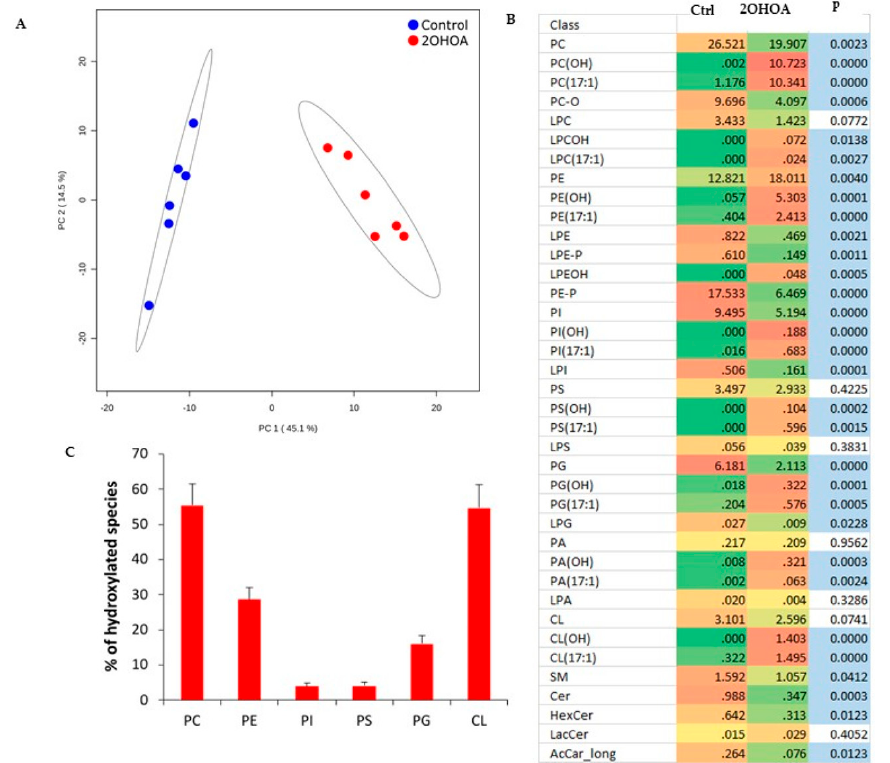
Figure 2. Comparative lipidomics of mitochondria isolated from U118MG cells, untreated, or treated with 200 µ M 2OHOA for 48 h. n = 6 replicates from each treated and untreated conditions were analyzed. ( A ) Principal component analysis scores plot of lipidomic dataset ellipses displaying 95% confidence regions. ( B ) Heatmap representation of 2OHOA-induced lipidomic changes at the level of lipid classes. OH and 17:1 suffixes indicate 2OHOA- and 17:1-incorporated lipid species, respectively. Blue fill indicates p < 0.05 (Student’s t -test). ( C ) Percentage of hydroxylated species relative to non-2OHOA-generated molecules. Shown are mean ± SEM. In addition to the acronyms in Figure 1B, the “L” prefix indicates the lyso derivatives of fully acylated lipid classes. LacCer, lactosylceramide.